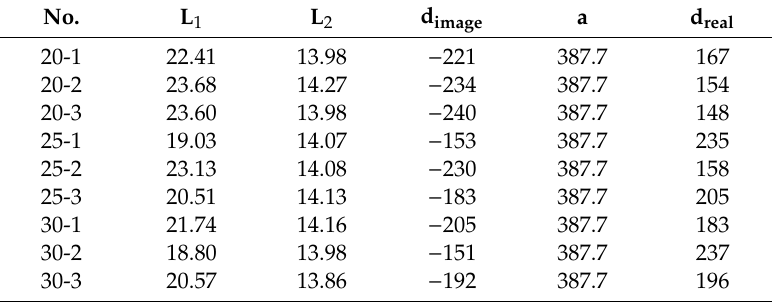
Table 6. Relative distance using a monocular camera (CPFC),